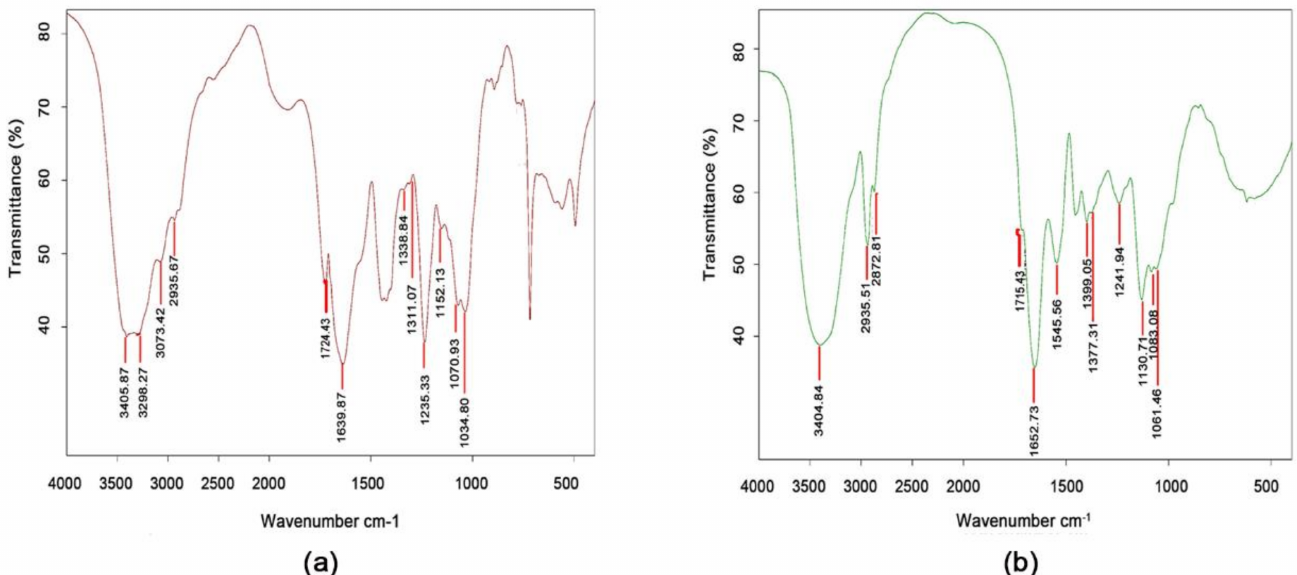
Figure 2. FTIR spectroscopy analysis. ( a ) The control without cross-linking; ( b ) The ammonium sulfate-induced